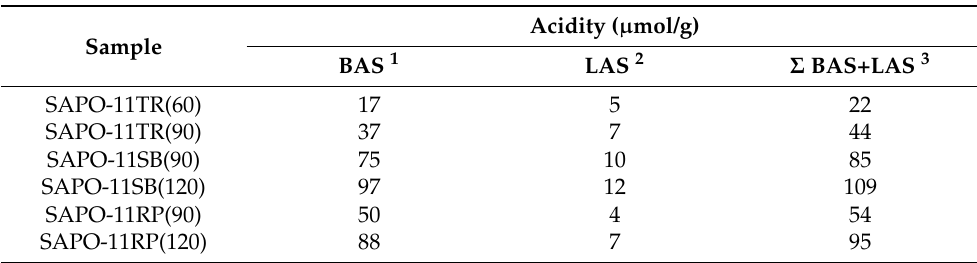
Figure 12. IR spectra of adsorbed pyridine for SAPO-11: ( a ) Sample SAPO-11TR(60); ( b ) Sample SAPO-11TR(90); ( c ) Sample SAPO-11SB(90); ( d ) Sample SAPO-11SB(120); ( e ) Sample SAPO-11RP(90); ( f ) Sample SAPO-11RP(120). Table 6. Acid Site Concentrations of SAPO-11 Silicoaluminophosphates According to IR Spectroscopy with Pyridine